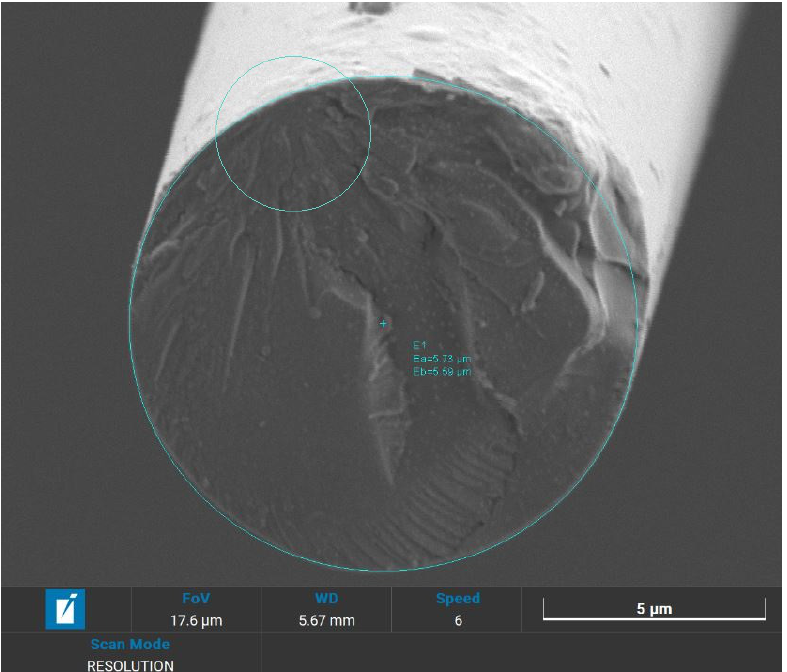
Figure 14. Fracture of recycled basalt single fiber nucleated from the surface: the small circle indicates the nucleation site.